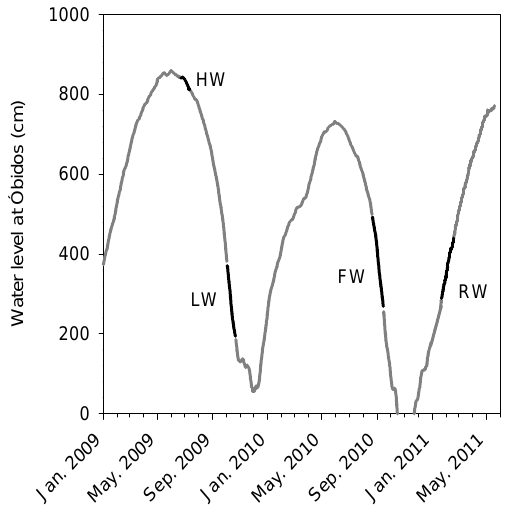
an . J Figure 2. Seasonal water level changes of the Amazon River main stem at the town Óbidos (RW = rising water, HW = high water, FW = falling water, LW = low